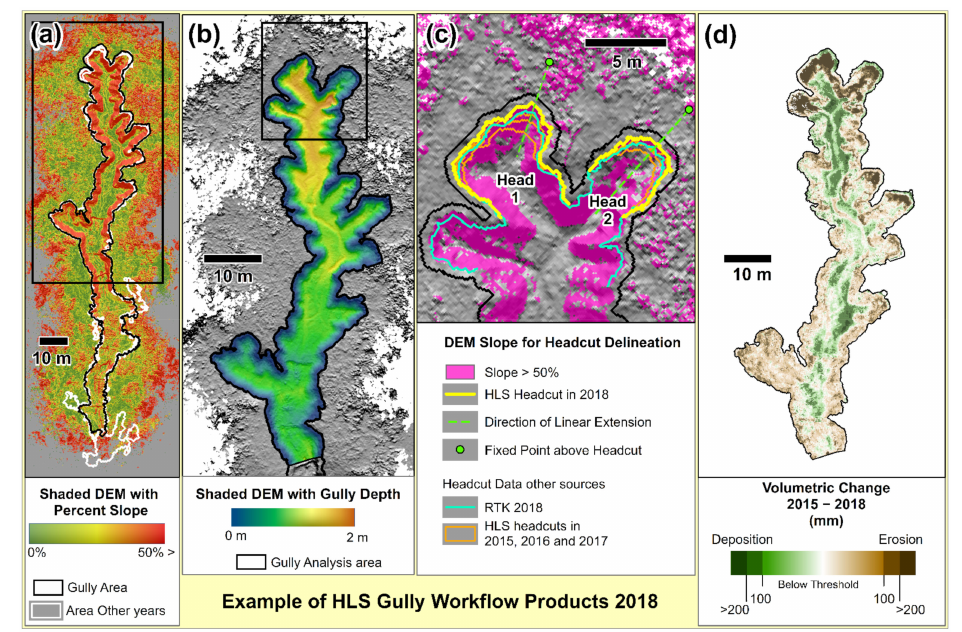
Figure 5. Example of HLS Gully Workflow products for 2018. Downstream end of gully is towards bottom of figure. Equivalent products were generated for all other years from 2015 to 2019 and some are shown. ( a ) Shaded relief using a 10 cm DEM overlain with slope grid (B in Figure 2) and full DFME gully areas in white. ( b ) 2018 Gully depth grid (D in Figure 2) clipped to gully area used in study (C in Figure 2) ( c ) Close-up of 2018 headcut in shaded relief showing slope >50% in pink. HLS headcut polyline is shown in yellow (for comparison, other years of HLS headcut polylines are shown in orange and 2018 RTK rim survey is shown in blue). Headcut area is the area between two polylines of different years (not shown). ( d ) Patterns of erosion and deposition detected in the DEM of Difference (F in Figure 2) over the 3 years from 2015 to